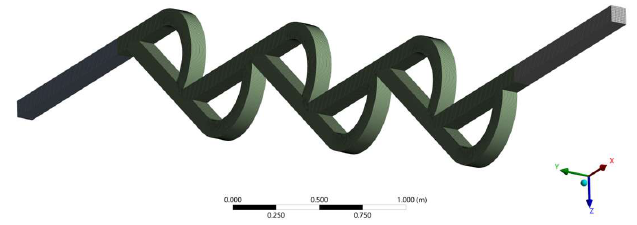
Figure 3. Schematic diagram of meshing (T45-R).